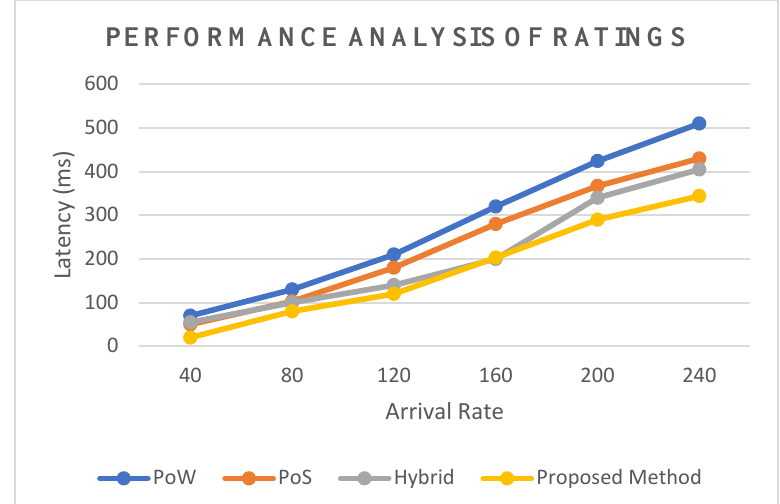
Figure 9. Performance analysis of ratings. Table 2. Comparative analysis of